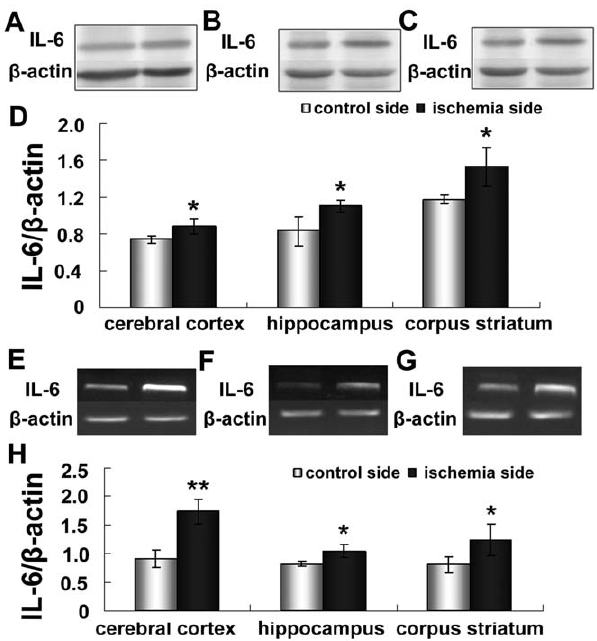
Figure 6. Expression of IL-6 mRNA and protein in ischemic brain. Rats were subjected to 60 min MCAO and 24 hour reperfusion. The IL-6 protein level of cerebral cortex (A), hippocampus (B) and corpus striatum (C) were analyzed Western blotting. The mRNA level of cerebral cortex (E), hippocampus (F) and corpus striatum (G) of contralateral and ipsilateral side was detected by RT-PCR. Fig 4D and Fig 4H show the summary of IL-6 protein and mRNA expression respectively. Results are presented as Mean 6 SEM, n=3. **p , 0.01 v.s. contraleteral side, *p , 0.05 v.s. contralateral side.